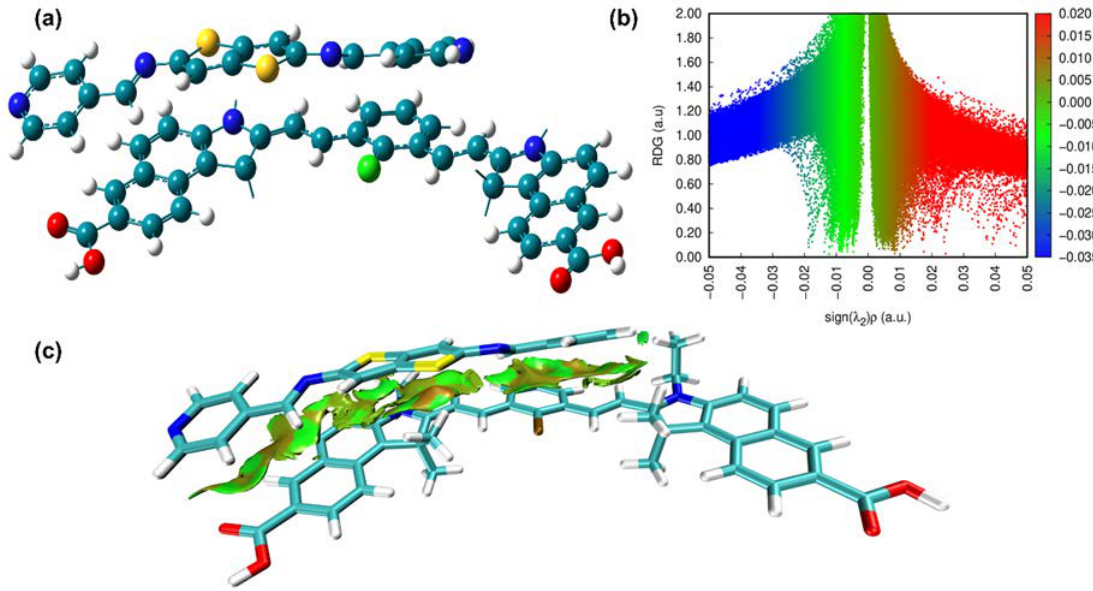
Figure 10. ( a ) Optimized geometry. ( b ) Scatter map of RDG versus electron density ρ ( r ) multiplied by the sign of second Hessian eigenvalue λ 2 , ( c ) RDG isosurface map for the Py-1/VG20 dimer.